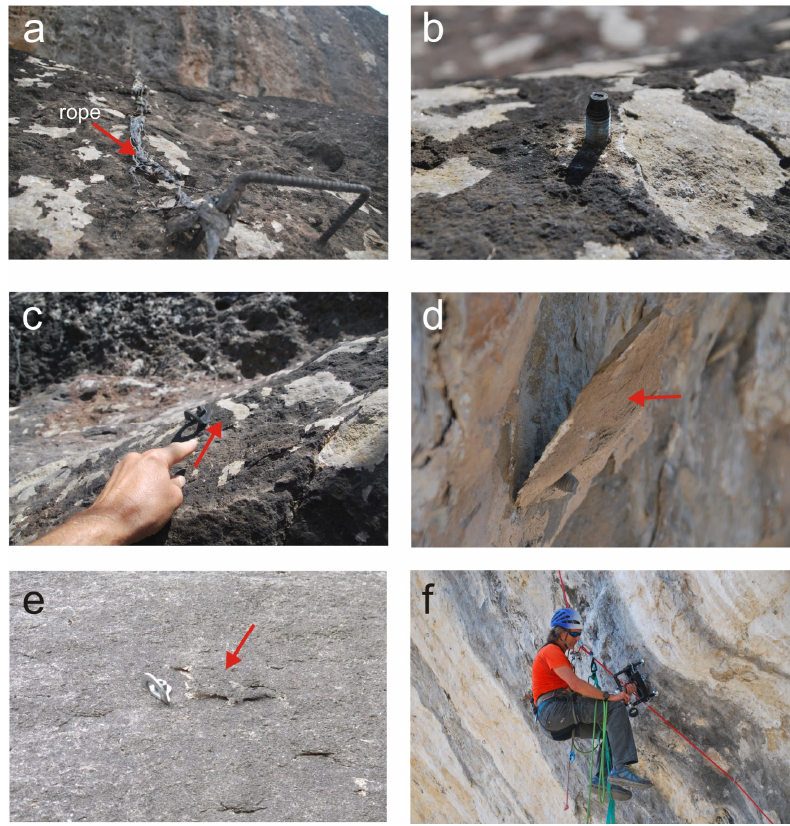
Figure 14. Impacts on climbing anchors: ( a ) remains of climbing ropes and iron stairs in